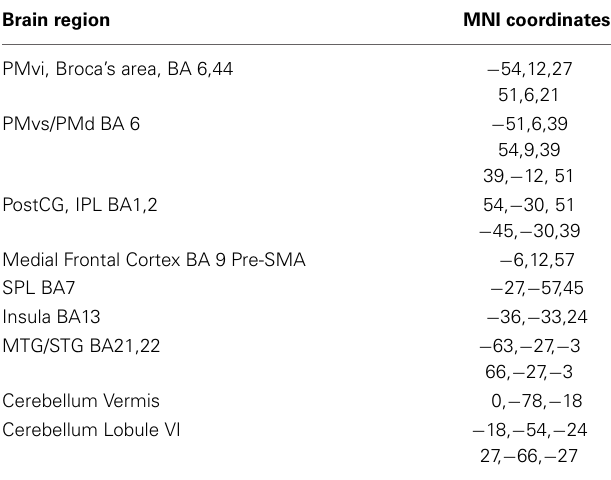
Table showing clusters of activity for the conjunction of all contrasts relative to rest (Eng Unaccented, Eng Unaccented, Jpn Accented, Jpn Unaccented) thresholded at pFDR < 0.05 corrected with an extent threshold greater than 5 voxels. Jpn., Japanese; Eng., English; Cor., corrected for multiple compar- isons; BA, Brodmann area; PMvi, Ventral inferior premotor cortex; PMvs, Ventral superior premotor cortex; PMd, Dorsal premotor cortex; PostCG, Postcentral gyrus; IPL, Inferior parietal lobule; pre-SMA, Pre-supplementary motor area; SPL, Superior parietal lobule; MTG, Middle temporal gyrus; STG, Superior tempo- ral gyrus. Negative × MNI coordinates denote left hemisphere and positive × values denote right hemisphere activity.